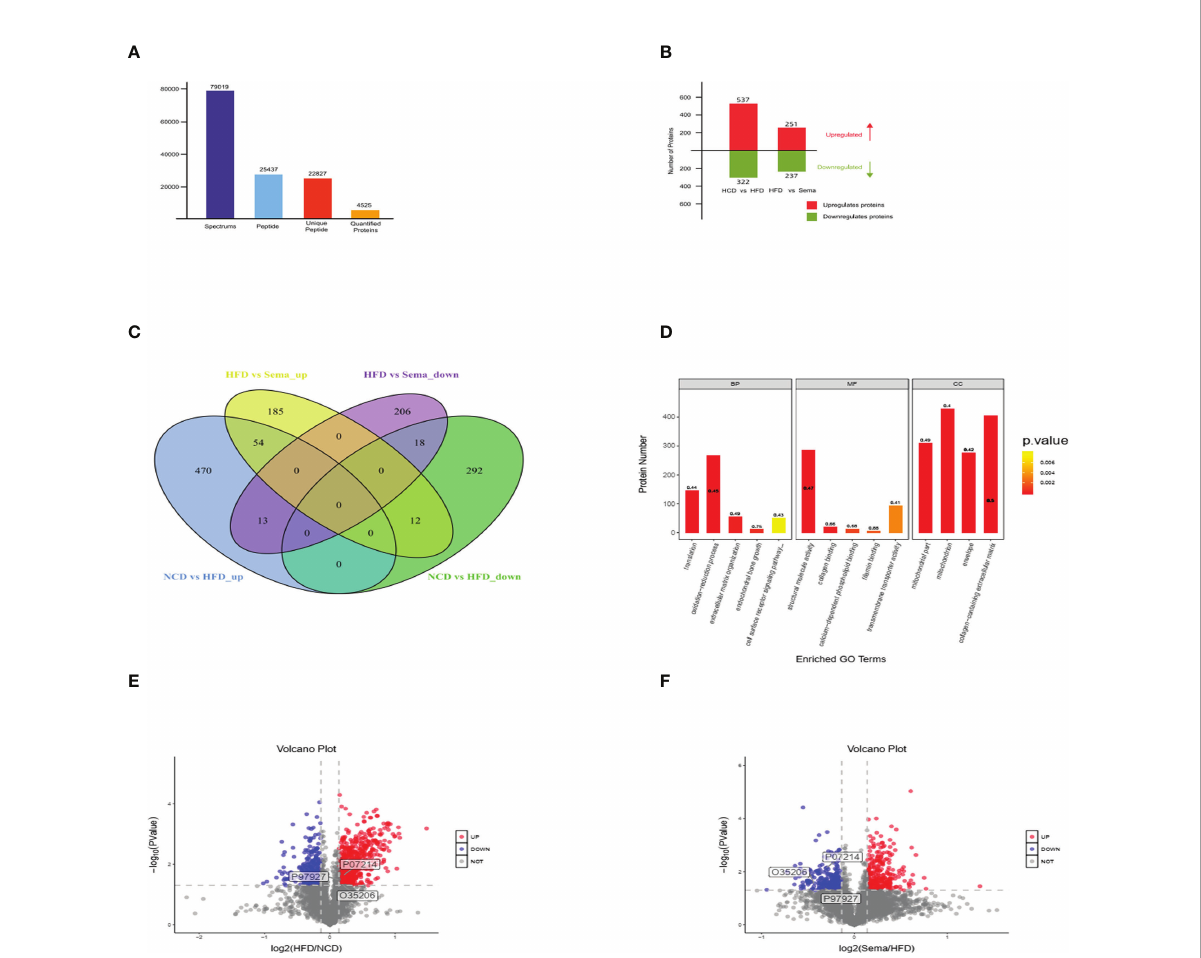
FIGURE 4 (A) LC-MS/MS Mass spectrometry (MS) analysis revealed in total 77,1849 spectrum proteins, 7,9019 matched-spectrum proteins, 2,5437 peptides, 22827 unique peptides, 4532 identi fi ed proteins and 4525 quanti fi able proteins. (B) The number of up-regulated and down-regulated proteins was compared between the two groups. (C) The number of up-regulated and down-regulated proteins was compared between the two groups in Venn diagram. (D-F) The volcano plot of DEPs, Signi fi cantly down-regulated proteins are marked in blue, signi fi cantly up- regulated proteins are marked in red, and indifferent proteins are marked in grey.